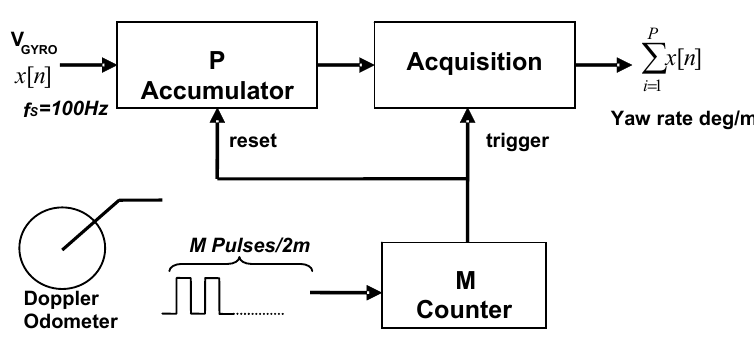
Figure 10. Simplified Distance sampler accumulator.